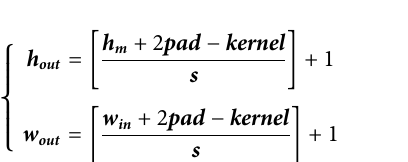
Frontiers in Materials |